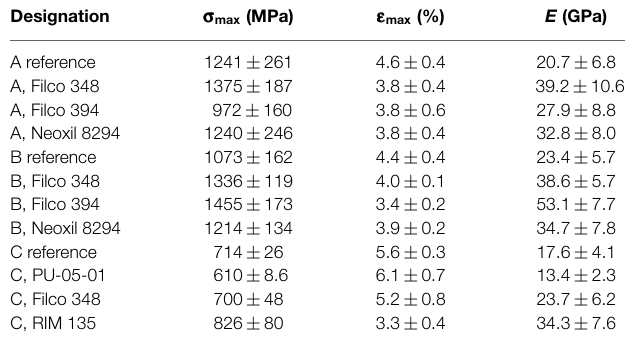
TABLE 3 | CNT fiber tensile test results as a function of coatings .